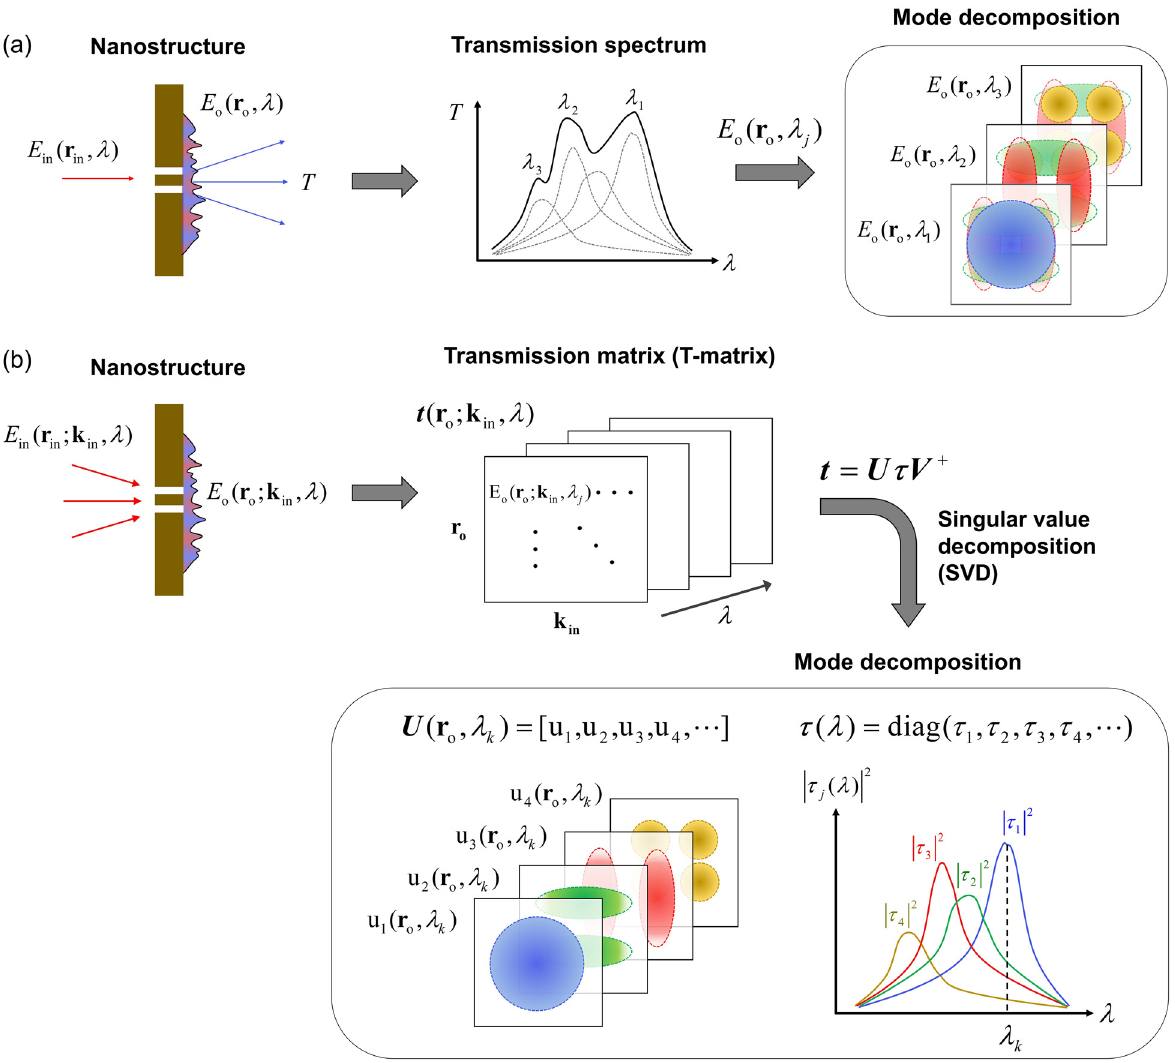
Figure 1: Comparison of mode analysis methods based on transmission spectrum and transmission matrix (T-matrix). (a) Processflow diagram of a conventional single-channel (i.e., single speci fi c k in ) transmission measurement analysis.Transmissionspectra (middlepanel)and fi eldpro fi les(rightpanel)ofthenano-opticalsystemobtainedthroughconventionalsingle-channeltransmissionanalysis. (b) Process fl ow diagram of a multi-channel (i.e., multiple k in ) measurement for the T-matrix-based mode analysis. The transmission matrix t ( r λ )isreconstructedforeachwavelengthfrommulti-channelmeasurements.Decompositionofthematrices t ( r o ; k in , singular value decomposition (SVD). Field pro fi les and energy spectra of each eigenmode of the nano-optical system extracted from U and τ ,